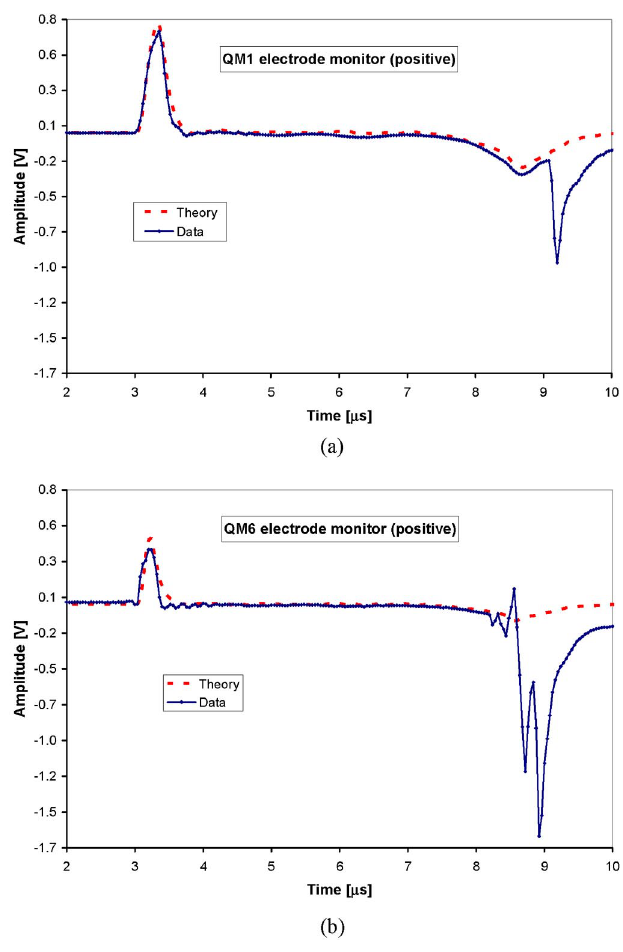
FIG. 13. (Color) Electrode monitors for the first (a) and last (b) electrostatic quadrupoles of the matching section. The blue curve is the raw signal across 10 (cid:28) . The dashed red curve is the expected signal derived from a current transformer waveform at the injector exit using Eq. (2). Note that the difference in peak amplitude for the head of the beam in the signals collected in QM1 and QM6 is due to the fact that QM6 is 30% shorter than QM1 and therefore the total charge subtended by the electrodes is proportionally lower in